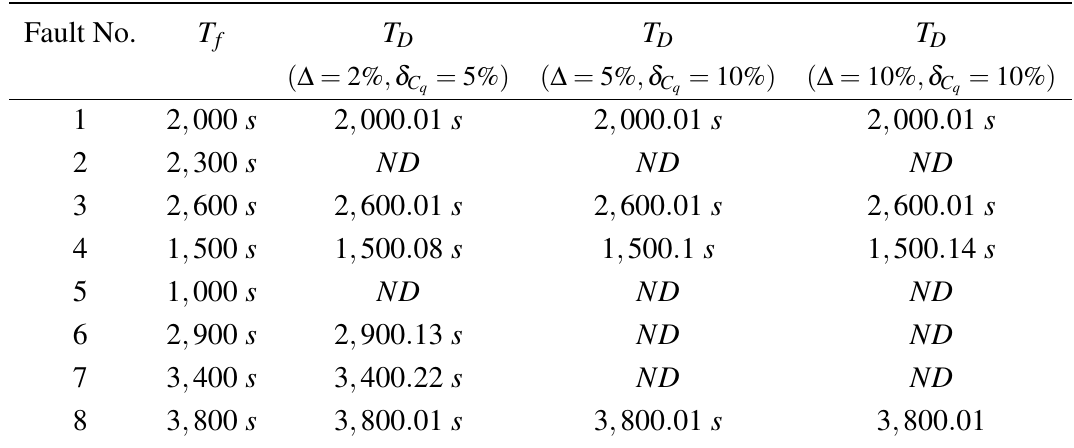
Table 8. Summary of fault detection